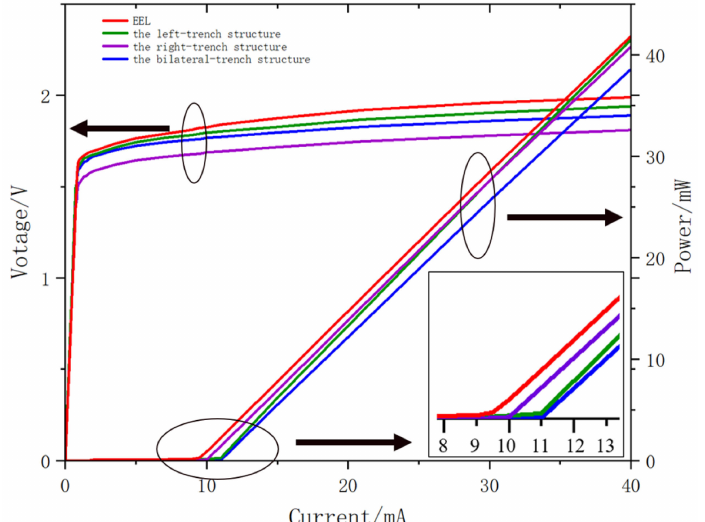
Figure 8. Power and voltage–current curves of the red, green, purple, and blue lasers with CW current. The record value for the maximum output power achieved by the lasers with the left trench groove structure was 6.99% higher than that of the bilateral trench